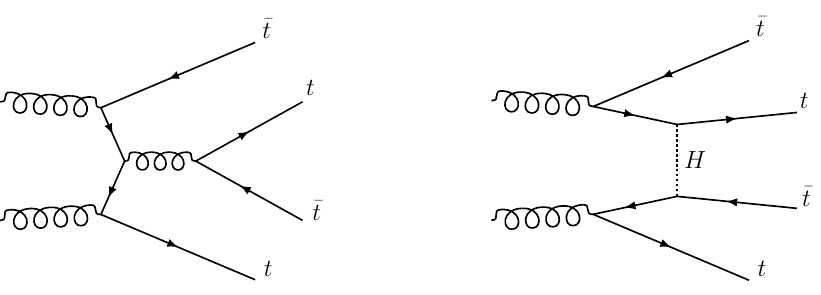
Figure 3 . Representative diagrams for the Born gg ! t (cid:22) tt (cid:22) t amplitude. The left diagram is of O ( (cid:11) 2 ), the right one is of O ( (cid:11) s (cid:11) ). Both diagrams involve tt ! tt scattering s